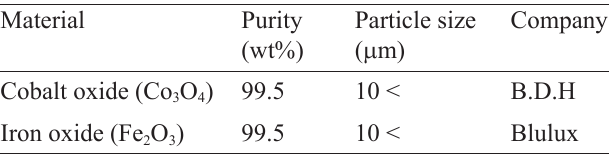
Table 1. Raw materials